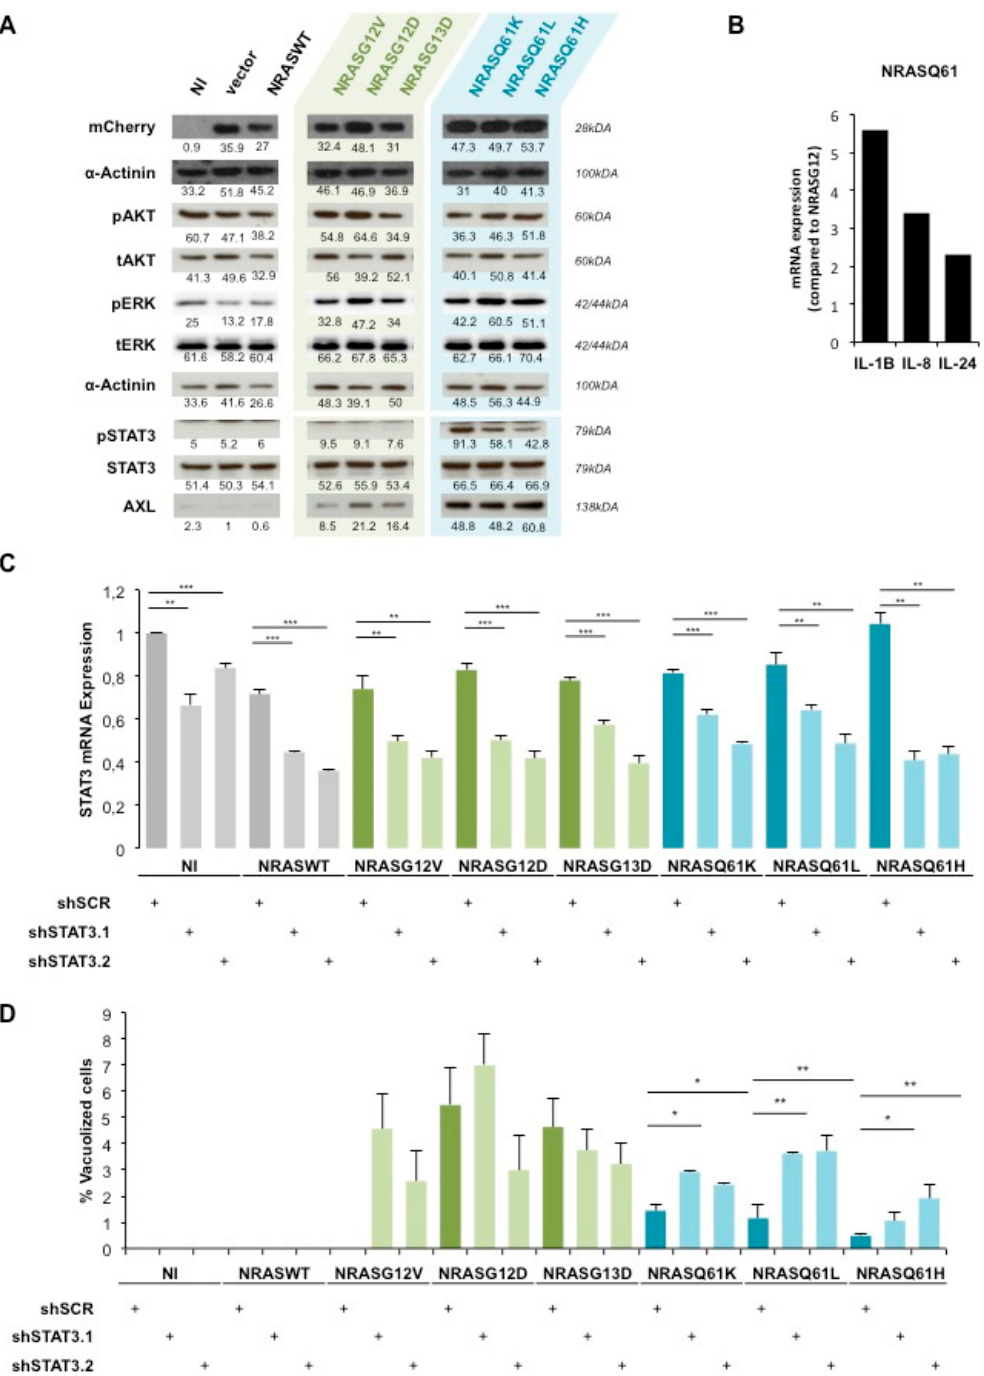
Figure 2. AXL / STAT3 axis is a key regulator of NRASQ61 —induced OIS in NHM. ( A ) Western Blot analysis of AKT, ERK and STAT3 activation status in NHM expressing indicated NRAS mutants. NI: